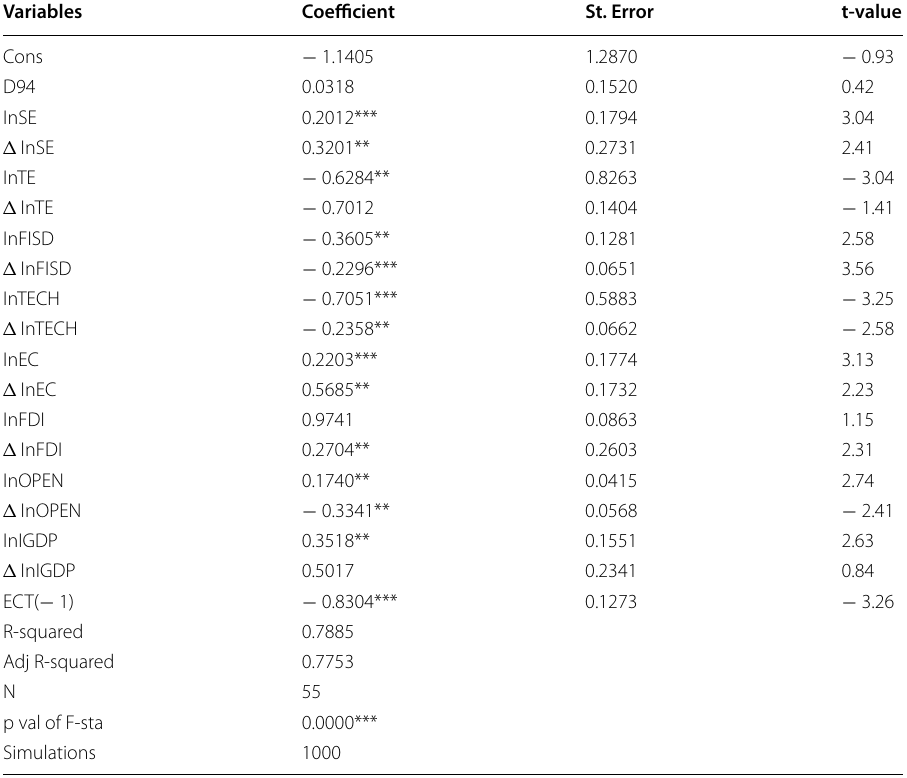
Table 11 Dynamic ARDL simulations analysis controlling for structural break